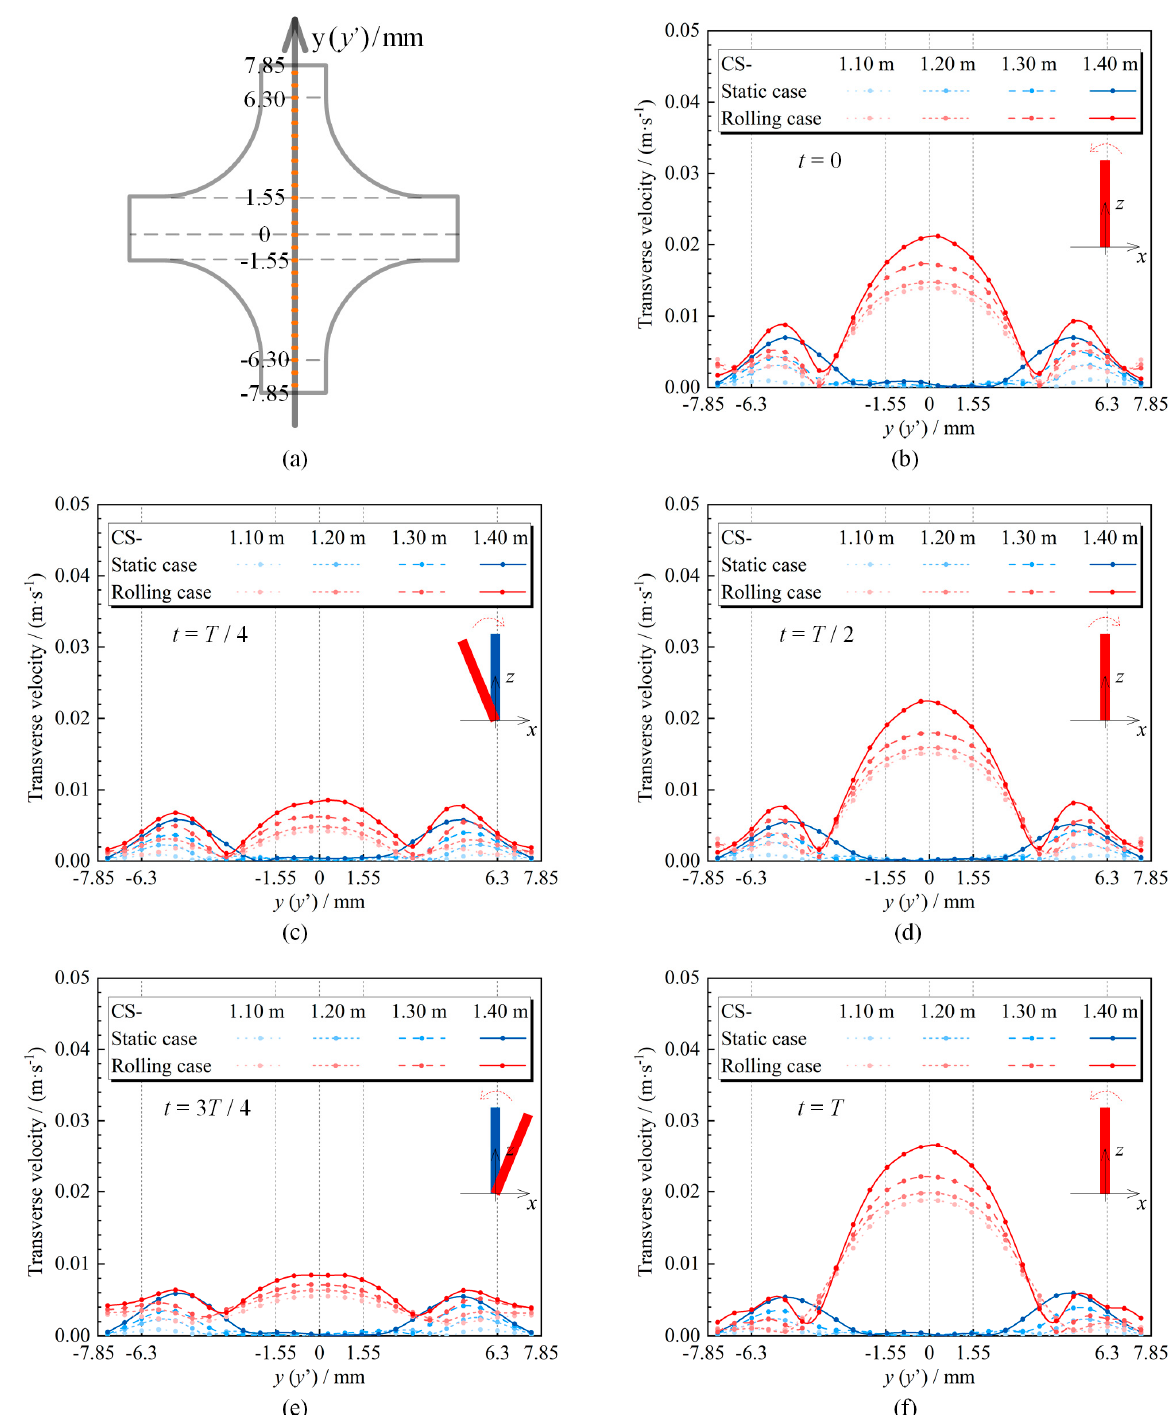
Figure 4. Transverse velocity profiles on the 𝑦 -axis ( 𝑦’ -axis). ( a ) Cross-section of the subchannel; ( b ) 𝑡 = 0 ; ( c ) 𝑡 = 𝑇/4 ; ( d ) 𝑡 = 𝑇/2 ; ( e ) 𝑡 = 3𝑇/4 ; ( f ) 𝑡 = 𝑇 .